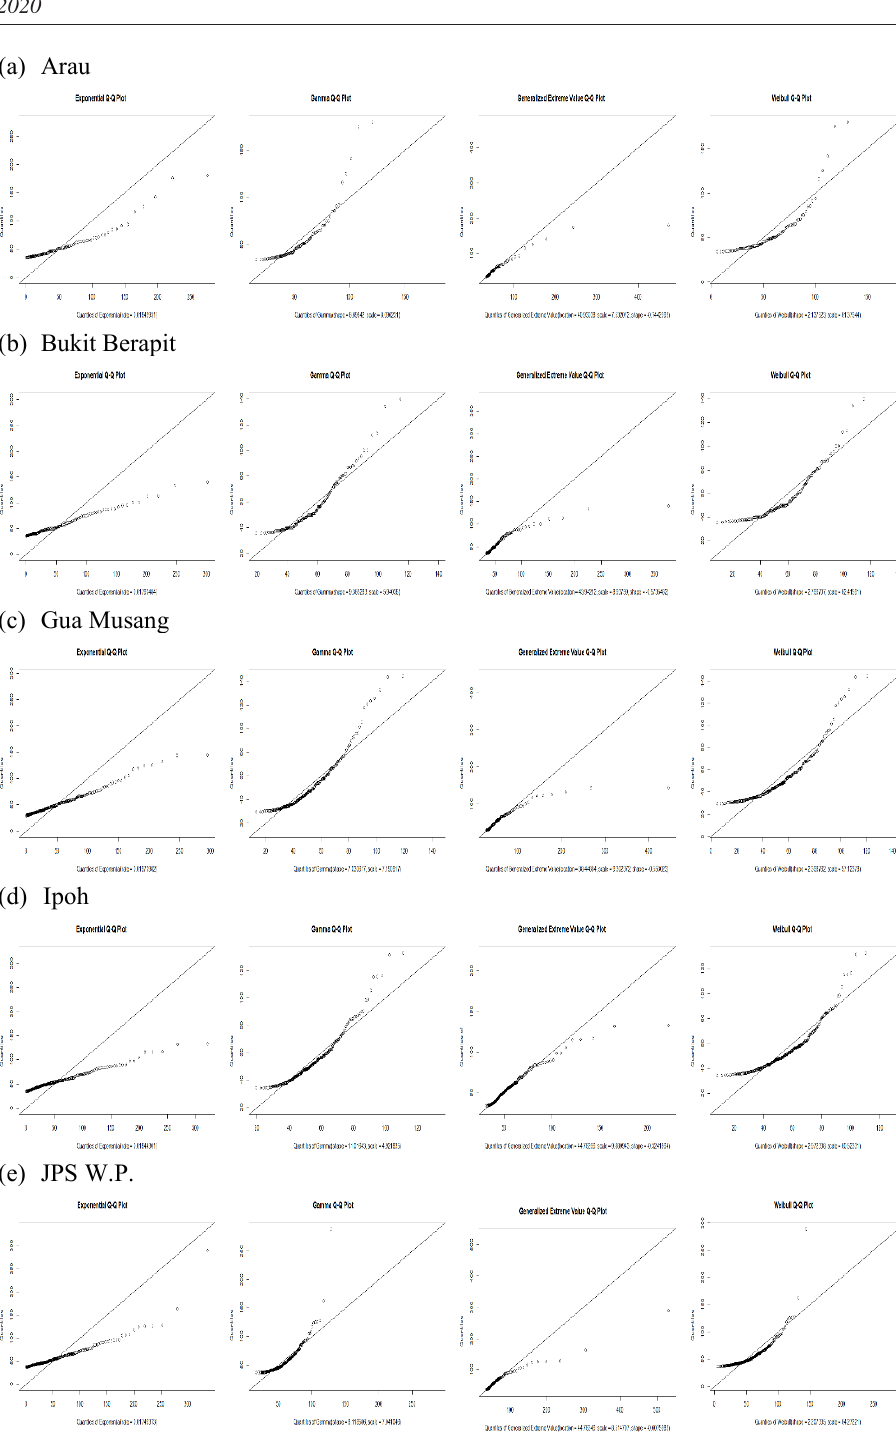
Fig. 2. Q - Q plots for selected rainfall with threshold of 90 th